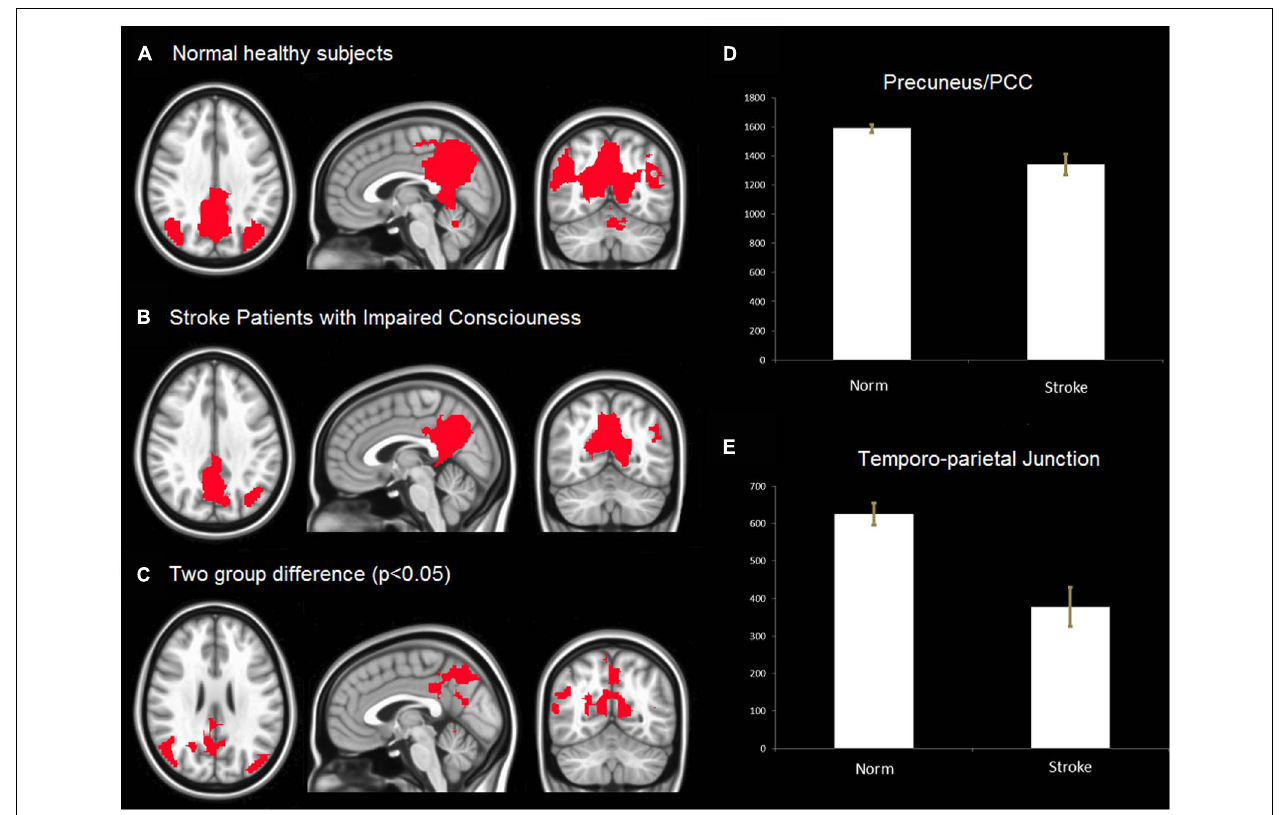
FIGURE 2 | (A) Default Mode Network (DMN) in healthy controls. The result was threshold at corrected p < 0.05 rendered on MNI152 template. (B) DMN of stroke patients with impaired consciousness threshold at corrected p < 0.05. The result was overlaid on MNI152 template. (C) The group difference of DMN. The result was threshold at corrected p < 0.05 and rendered on MNI152 template. (D,E) voxels ( T > 3.2) number of